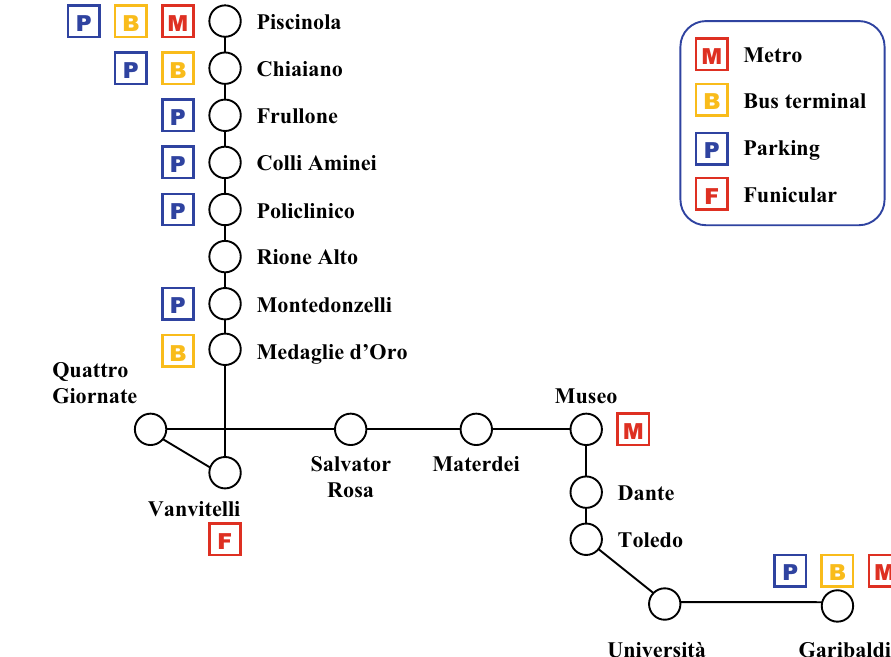
Fig. 3 Line 1 of the